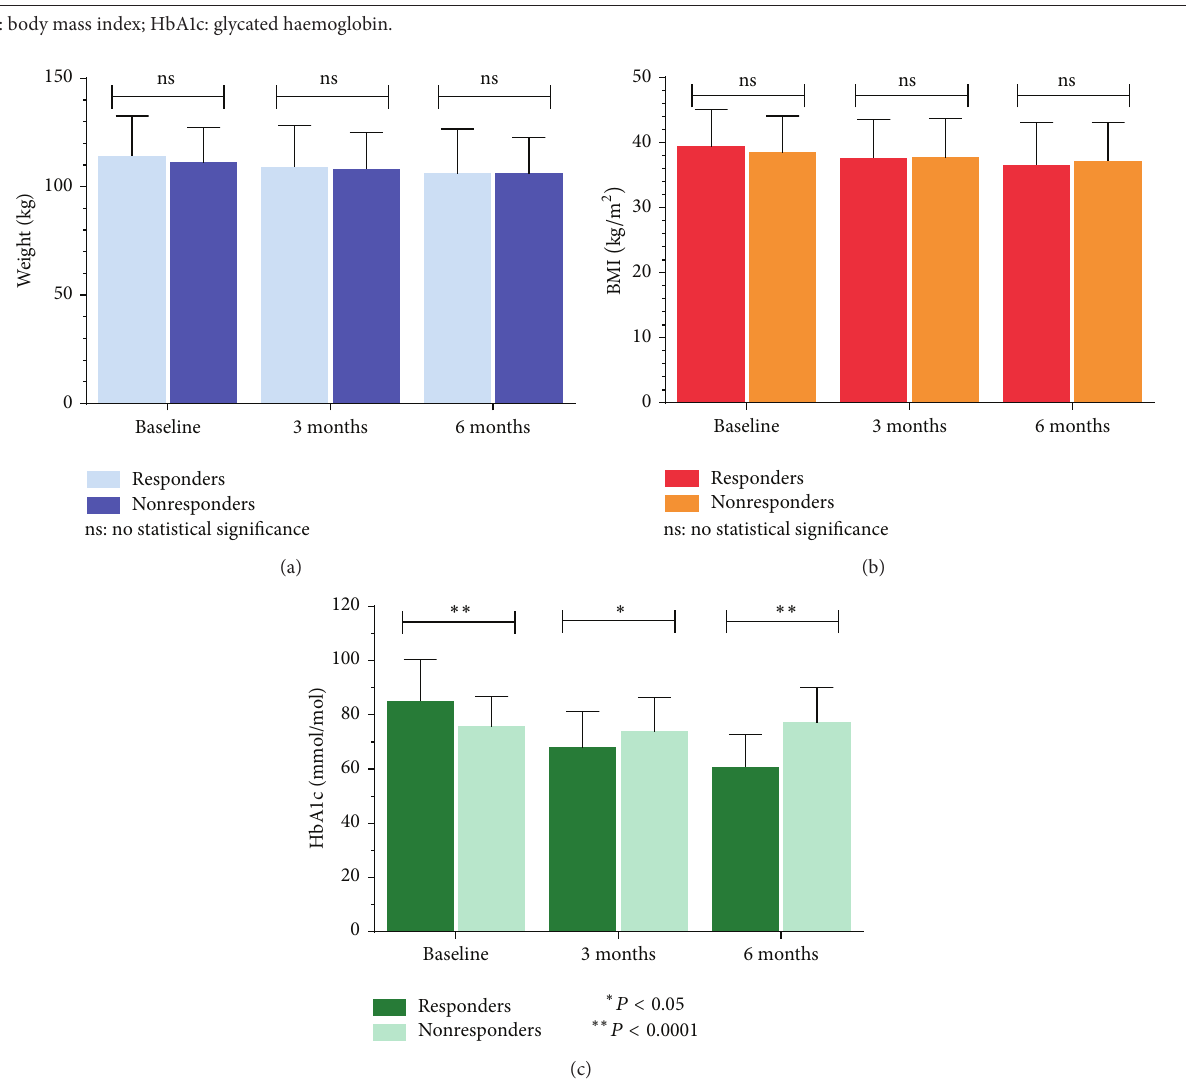
Figure 1: Mean ( ± 1 SD) changes in weight (a), BMI (b), and HbA1c (c) between responders ( 𝑛 = 63) and nonresponders ( 𝑛 = 49) at baseline, 3 months, and 6 months. NS denotes no statistical significance between groups. Asterisks denote statistical significance where ∗∗ is a 𝑃 value < 0.0001 and ∗ is a 𝑃 value < 0.05. Abbreviations: BMI, body mass index; HbA1c, glycated